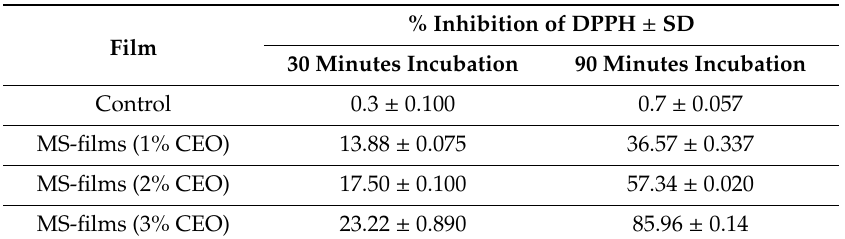
Table 3. Antioxidant activity of millet starch (MS) edible film incorporated with